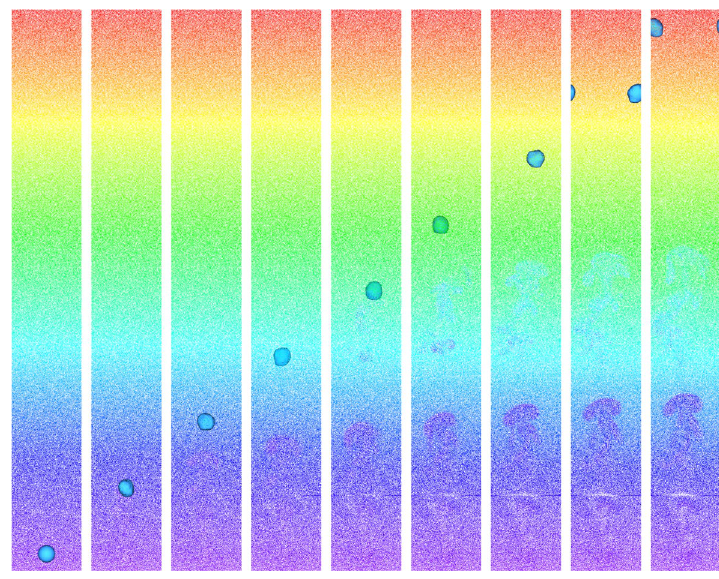
Fig. 1 Illustration of the simulation for the rising bubble (particles do not stick to the bubble). The bubble ascends in a spiral as a result of non-laminar flow. Particles are colored by initial z -position. Images are not in uniform time intervals, but in uniform intervals of traveled distance. This figure is provided as a video in the Supplementary file